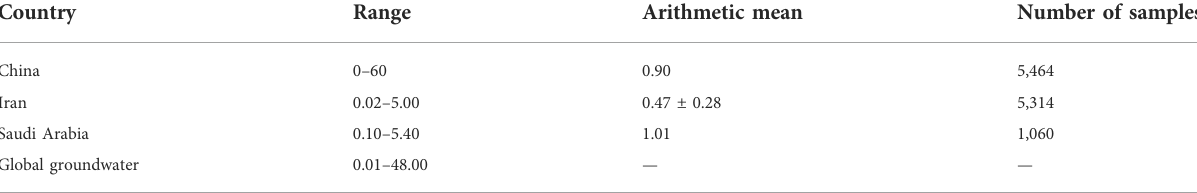
TABLE 1 F - content in shallow groundwater in China, other countries and